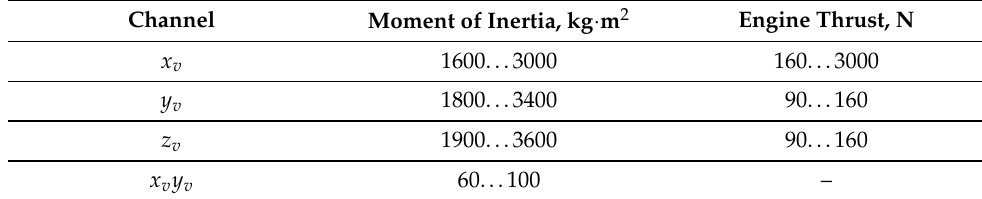
Table 6. Characteristics of the spacecraft and engines (test version).